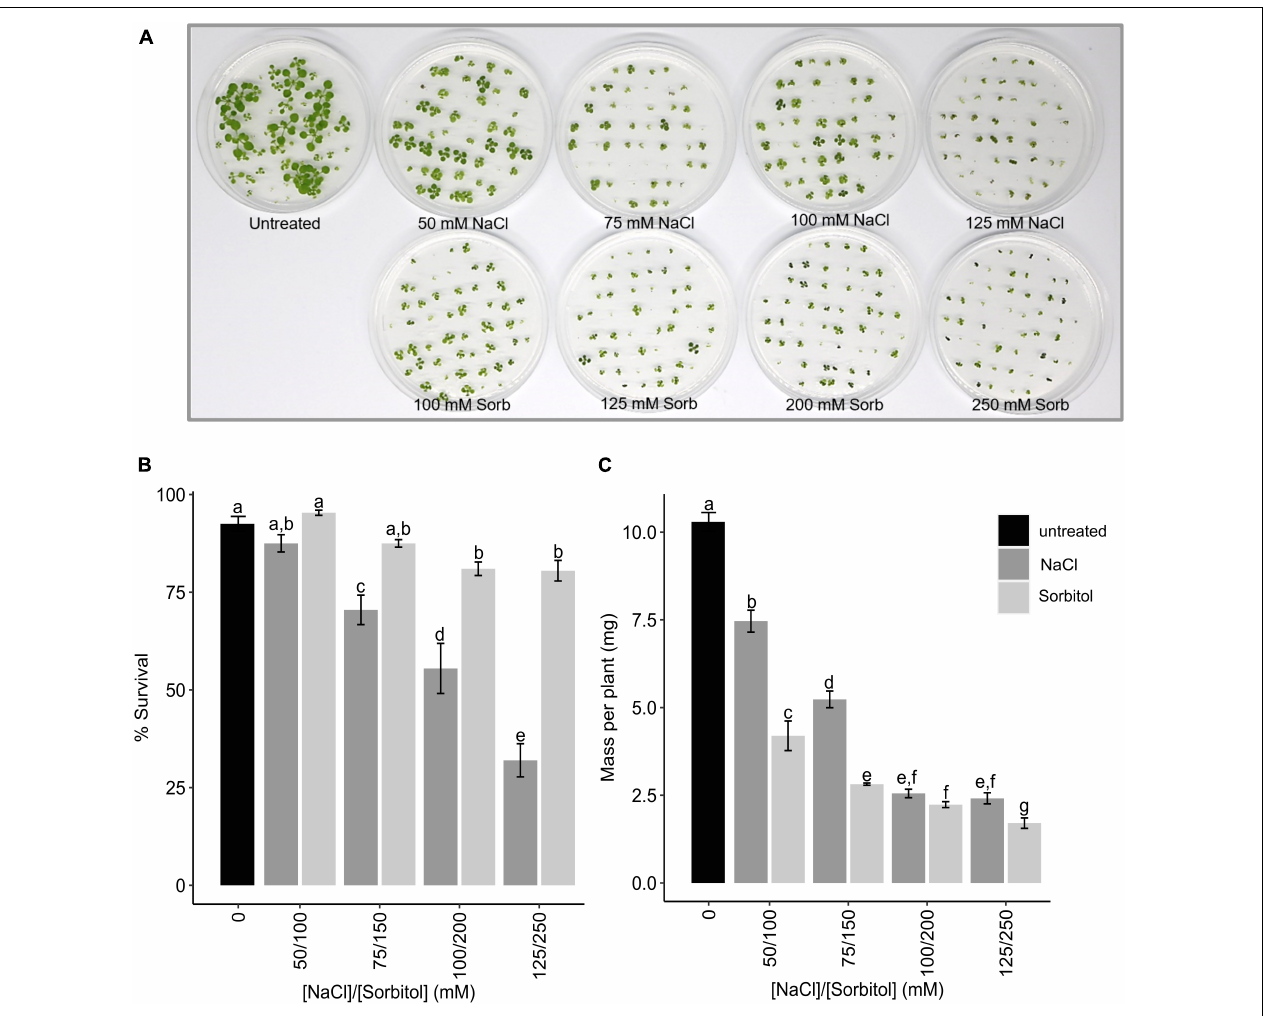
FIGURE 1 | Survival and mass of Arabidopsis Col-0 plants grown on NaCl and sorbitol. Col-0 was germinated and grown for two weeks in petri dishes containing ATS media (0 mM, untreated control) and ATS supplemented with the indicated concentrations of NaCl and sorbitol (Sorb) and survival and plant growth (mass per plant) determined. (A) A photograph of the Arabidopsis plants after two weeks growth on each treatment. (B) The mean% survival of Col-0 after two weeks growth on each treatment. (C) The mean mass per plant of Col-0 after two weeks growth on each treatment. The black bar represents the untreated control, dark gray bars represent NaCl treatments and light gray bars represent sorbitol treatments. The results are an average four petri dishes per treatment with 50 seedling sown per petri dish. Error bars represent standard error. Different letters on the graphs indicate statistically significant differences ( p ≤ 0.05) in mean% survival/mass per plant, determined by one way ANOVA followed by Fisher LSD post hoc